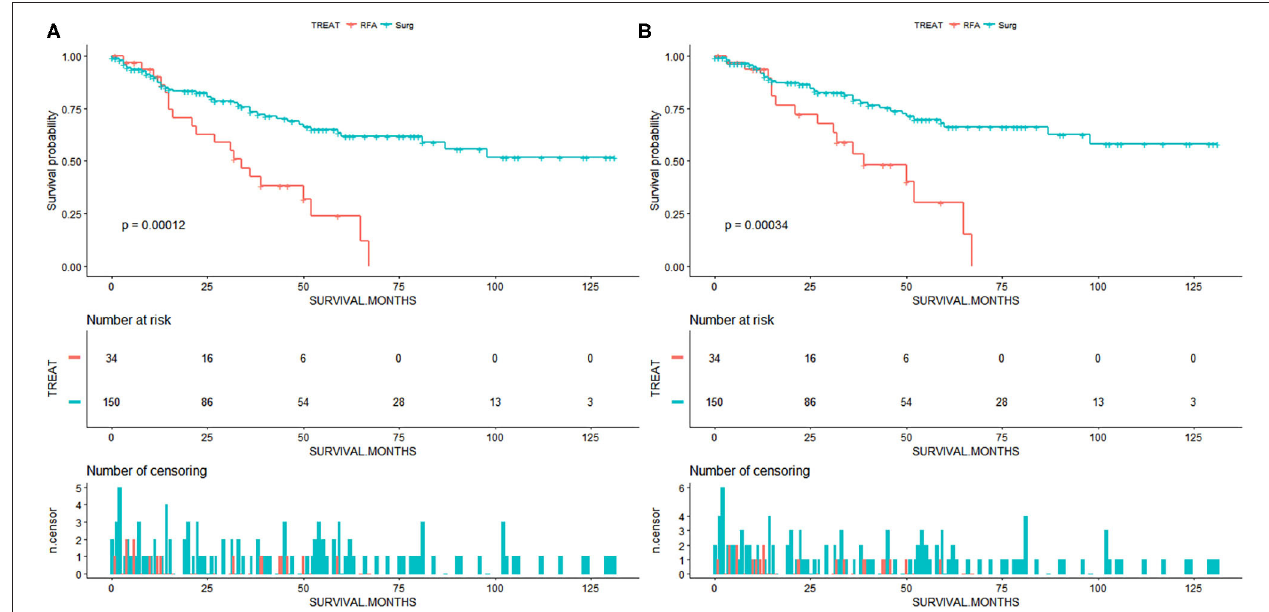
FIGURE 2 | (A) Overall survival for patients with small and early-stage intrahepatic cholangiocarcinoma. (B) Cancer-specific survival for patients with small and early-stage intrahepatic cholangiocarcinoma. Surg, surgical resection; RFA, radiofrequency